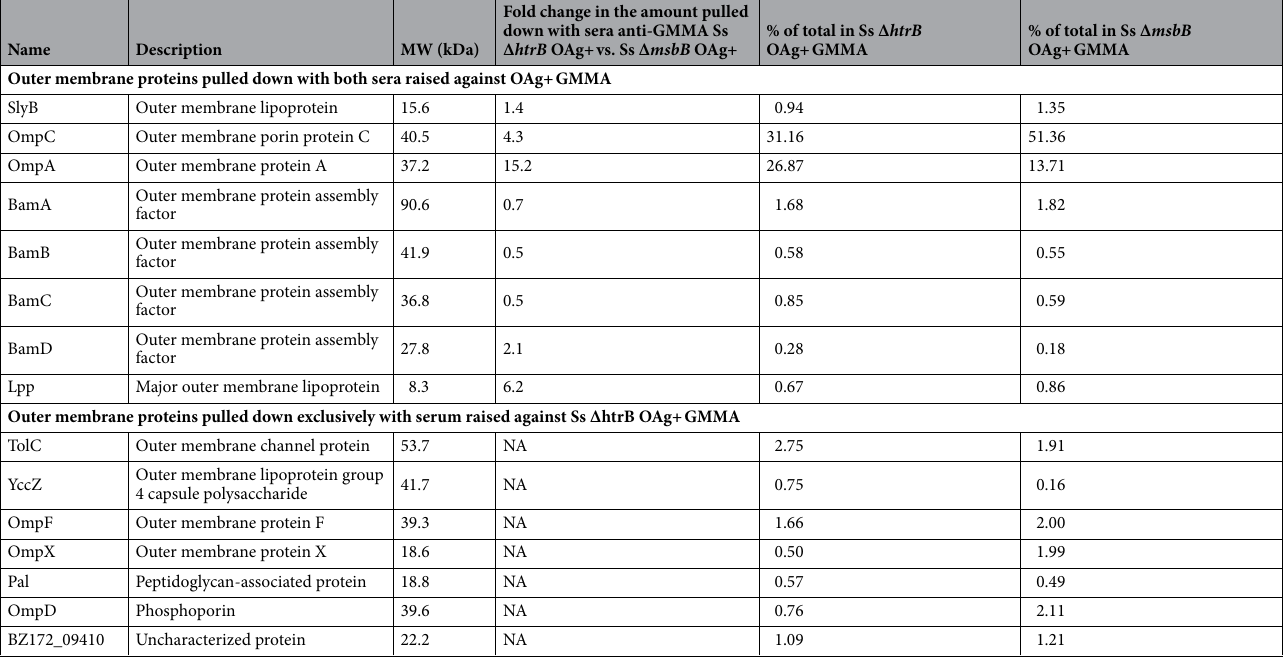
Table 3. Proteins identified through immunoprecipitation of GMMA proteins with sera from groups immunized with OAg-positive GMMA. GMMA surface immunoprecipitation was performed with pooled sera from mice immunized with OAg-positive GMMA to detect the protein antigens that are mainly recognized by the two sera and therefore to identify the immunodominant protein antigens in both GMMA preparations. OAg-negative GMMA carrying wild-type lipid A were used for the immunoprecipitation experiments and the precipitated proteins were identified and quantified by LC–MS/MS. A total of 15 outer membrane proteins were identified and quantified in the pulled down samples. NA not